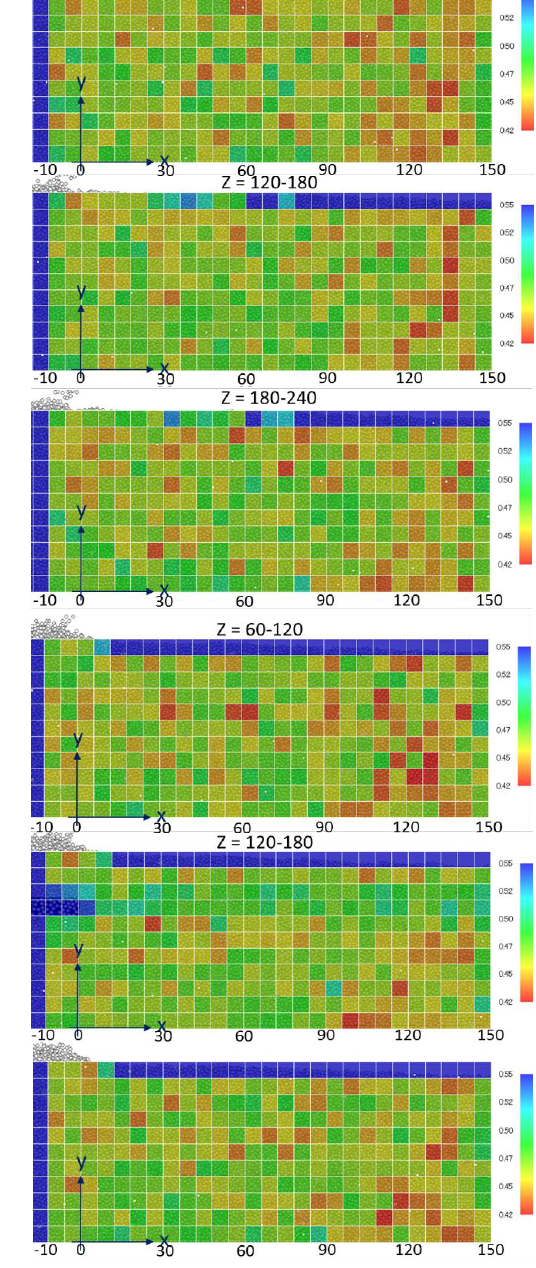
Figure 5. The influence of ventilation bar on the porosity of the packed bed.